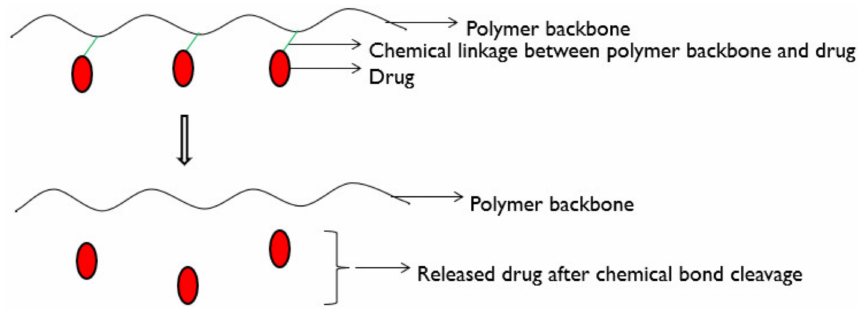
Figure 31. Polymer-drug conjugate systems.